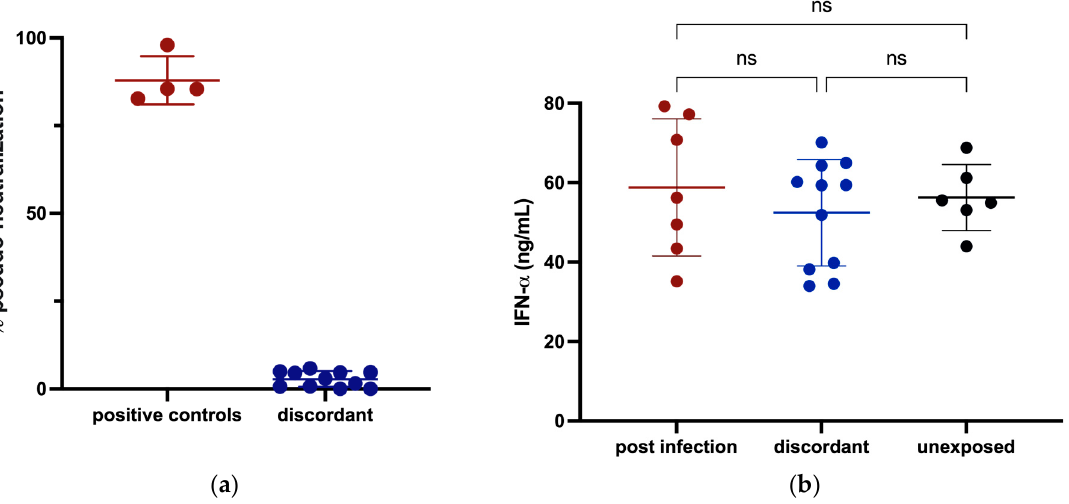
Figure 2. Assessment of potential for innate protection against SARS-CoV-2 infection measured by ELISA. ( a ) The ability of plasma from discordant subjects to inhibit the SARS-CoV-2 S interaction with ACE2 was tested with plasma from previously infected subjects included as positive controls. ( b ) Circulating IFN- α levels in plasma from discordant subjects and age- and sex-matched previously infected and unexposed individuals were measured and compared. Red, blue and black shading of dots represents positive controls, discordant case subjects and unexposed subjects respectively. The probability of a significant difference between groups was calculated using the Mann–Whitney test, with ns (not significant) shown above lines spanning the groups